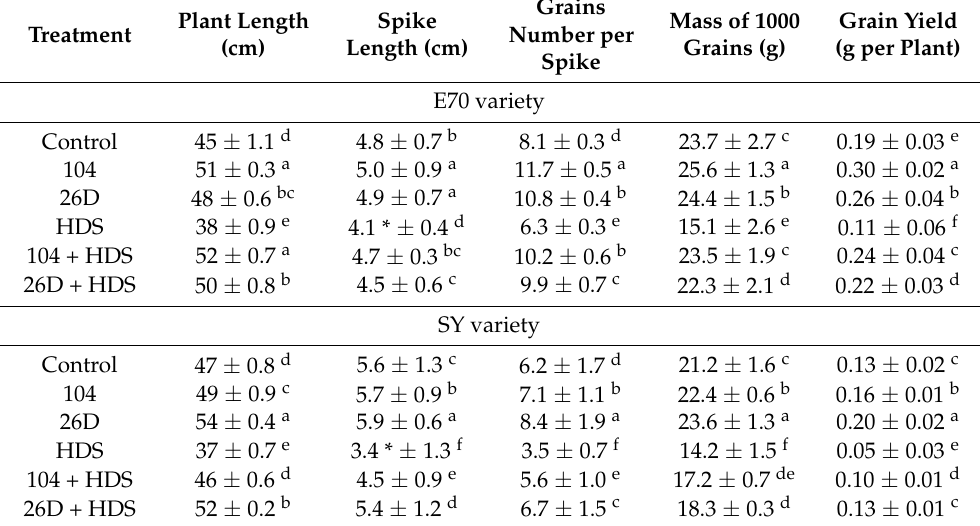
Figure 8. Effect of B. subtilis 104 and 26D on proline content in two wheat varieties E70 ( A ) and SY ( B ) under combined herbicide + drought stress (HDS) and after 4 days of normal irrigation (recovery). Error bars represent standard errors ( ± SE). Various letters show a significant difference between the averages of different groups at p < 0.05. Table 2. Effect of seed priming with B. subtilis 104 and 26D on the formation of yield elements of soft spring wheat under normal and HDS conditions. In the table standard errors ( ± SE) of the means in triplicate are represented. In each replicate, 25 plants were used. Various letters show a significant difference between the averages of different groups at p <